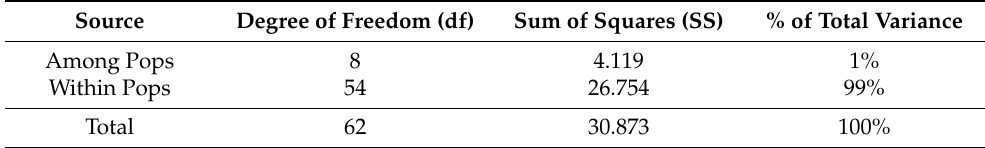
Table 6. AMOVA of wheat varieties using inter-Primer Binding Site (iPBS) marker. Source Degree of Freedom (df) Sum of Squares (SS) % of Total Variance Among Pops 8 Within Pops